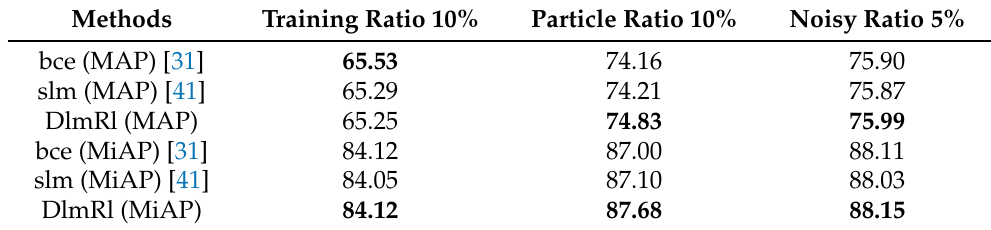
Table 2. MAP and MiAP score (%) of different methods on